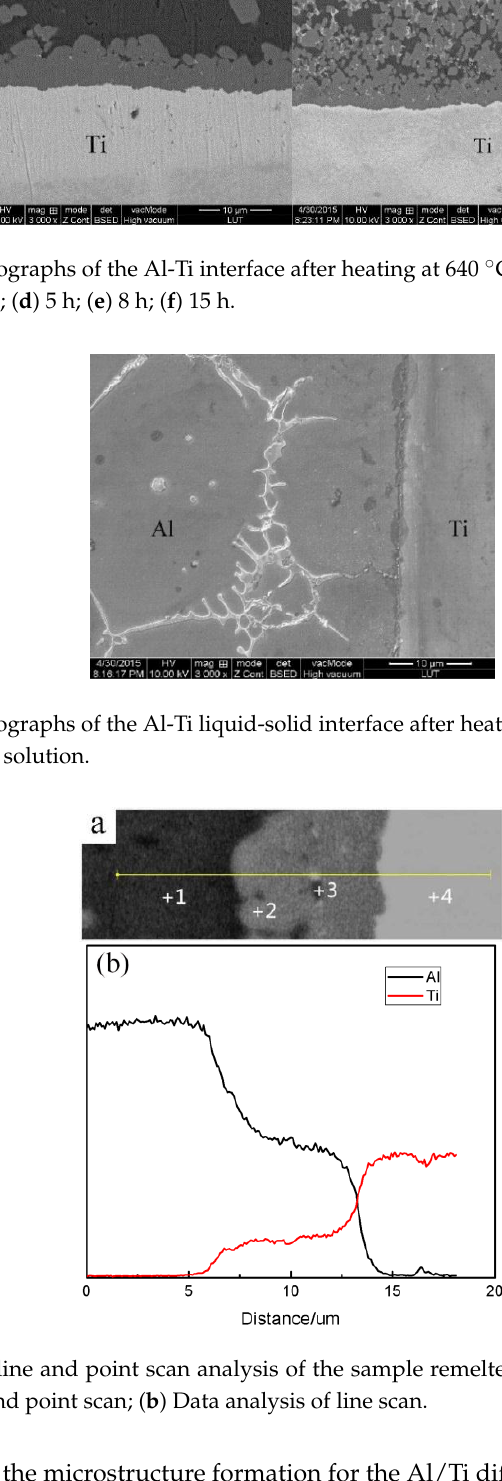
Figure 17. An SEM micrograph of the Al/Ti interface after heating for 5 h. To further investigate the growth mechanism for intermetallic compounds, the total intermetallic thickness is plotted against the reaction time in Figure 18a. The measured layer thickness x vs. time t can be modeled with an empirical power law relationship provided by Equation (6) [32,33]:   n tAxx  0